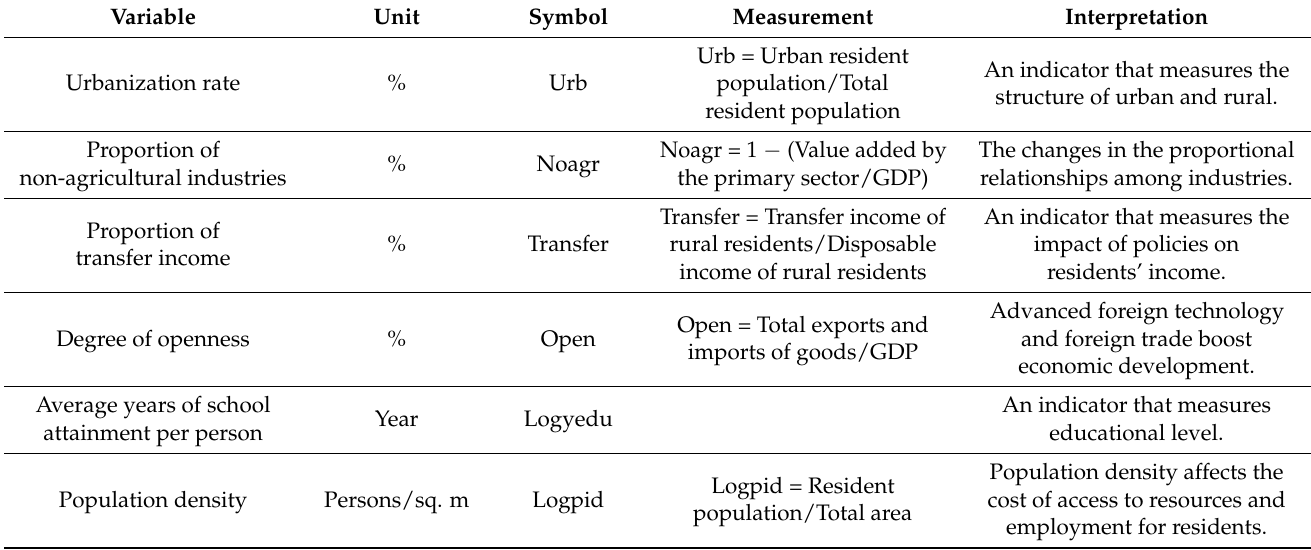
Table 2. Variables for analysis.